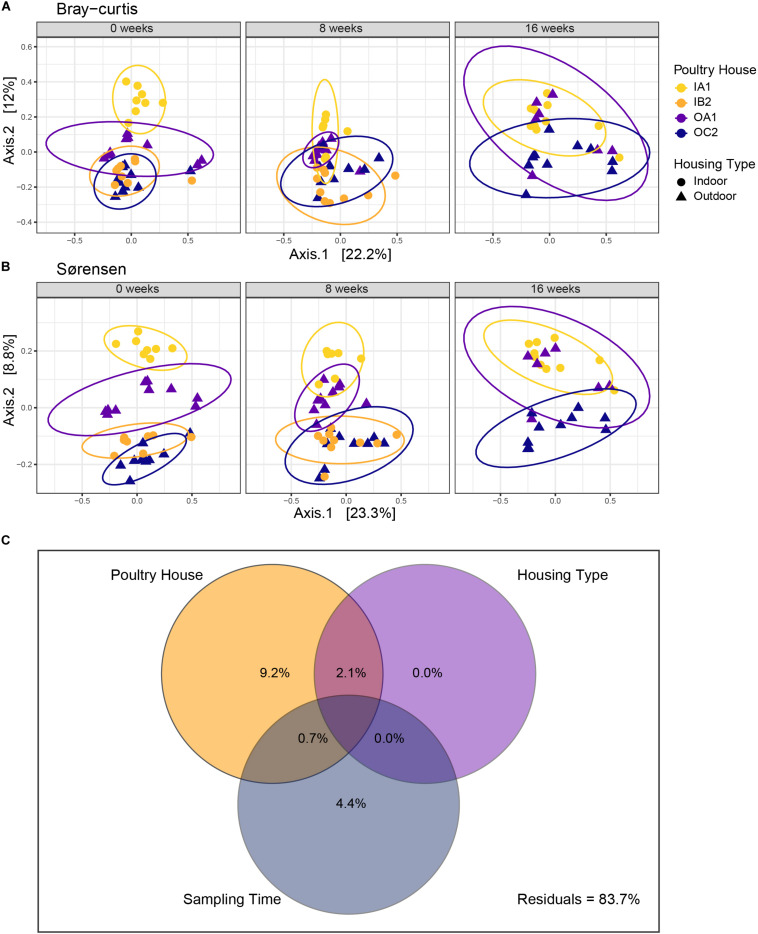
Principal coordinate analysis (PCoA) of Bray–Curtis (A) and Sørensen (B) dissimilarities. Each PCoA is faceted per sampling time, with ellipses encircling poultry houses. Each symbol represents an individual chicken. Time is shown as weeks since first sampling. (C) Distance-based partitioning of Bray–Curtis dissimilarities with poultry house, housing type and sampling time as explanatory variables. Adjusted R2 are shown in each circle. The model explains 14.8% of variation in community composition overall.